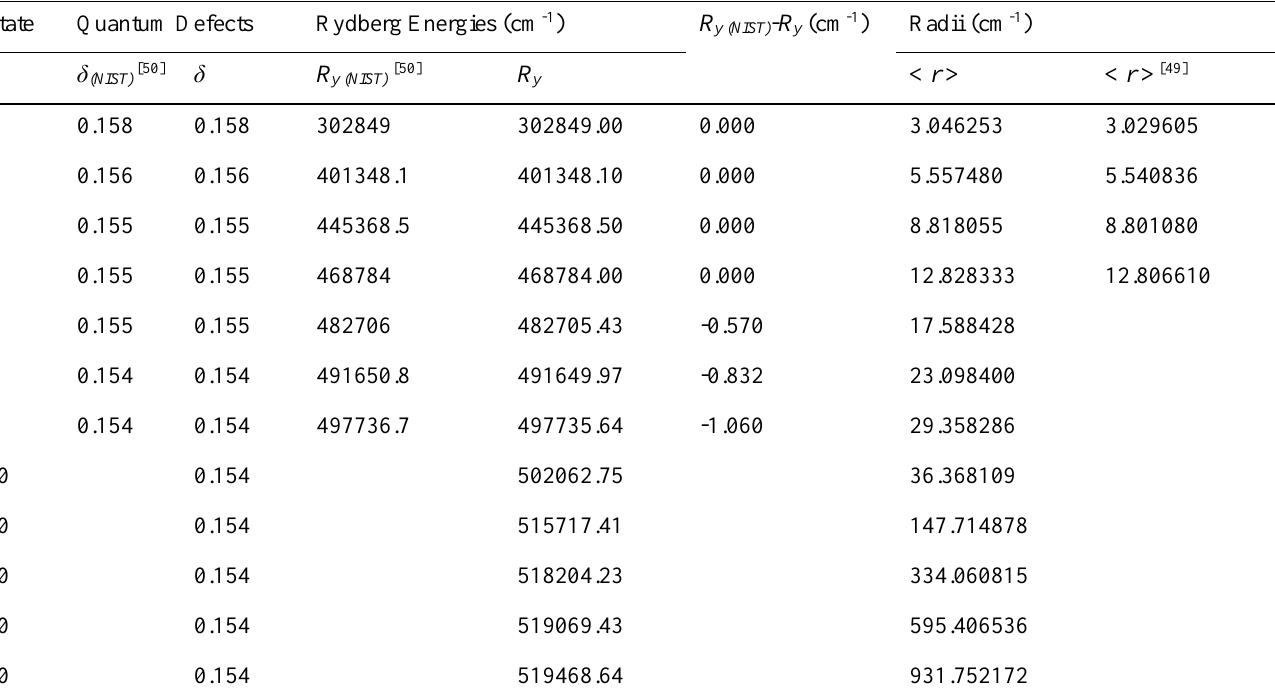
Spectral Rydberg Energy Series with Quantum Defects and Radii of Li iso-electronic sequence in 1 s 2 ns 2 S e 1/2 (C IV)